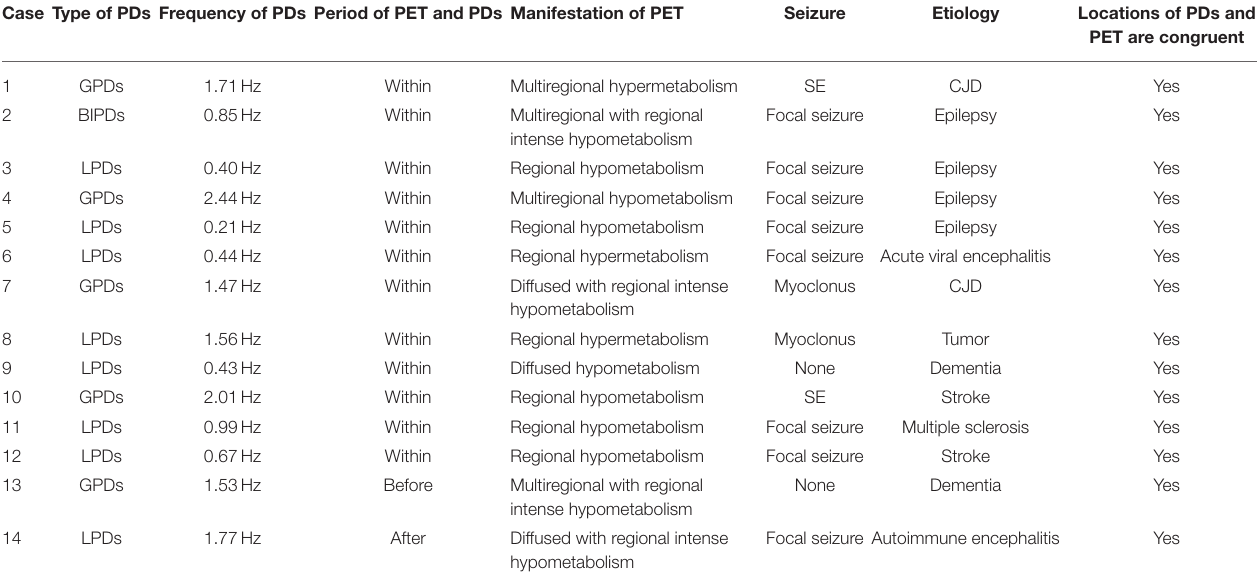
TABLE 1 | Manifestation of FDG-PET in patients with the PDs